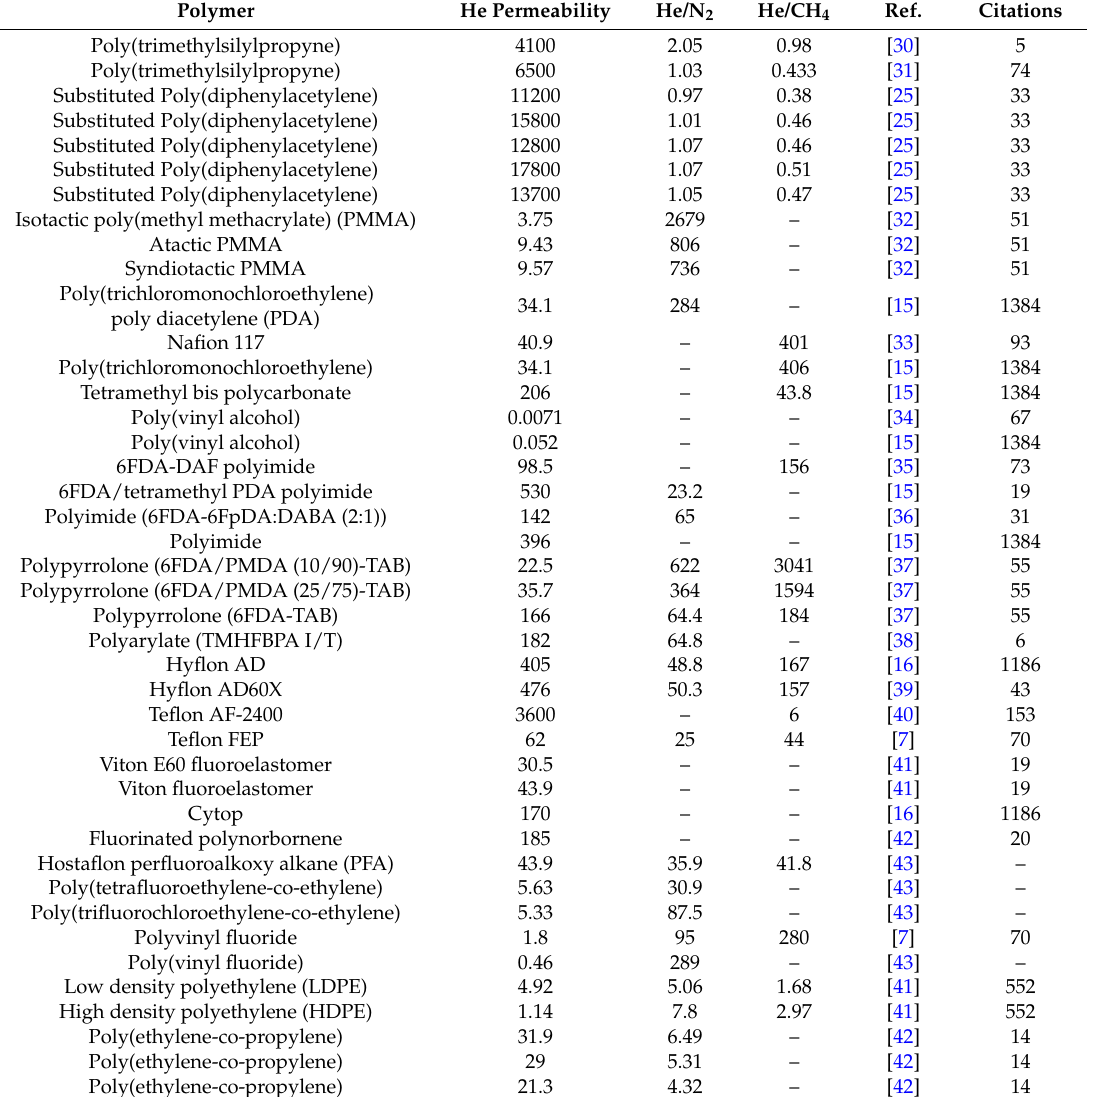
Table 2. He permeability (Barrer), He/N 2 and He/CH 4 selectivities in a range of polymeric membranes.